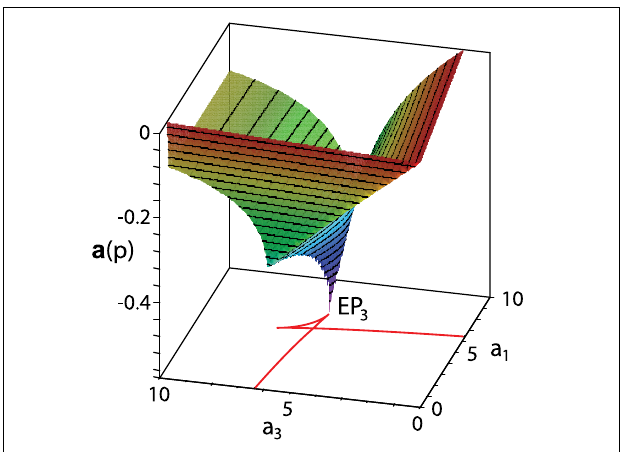
FIGURE 7 | When a 2 is restricted to 10, the abscissa of (5) reaches its minimum at the triple negative real root − √ 3. The red curve is a cross-section of the discriminant surface (17) a 3 = 28 9 by the plane a 2 =